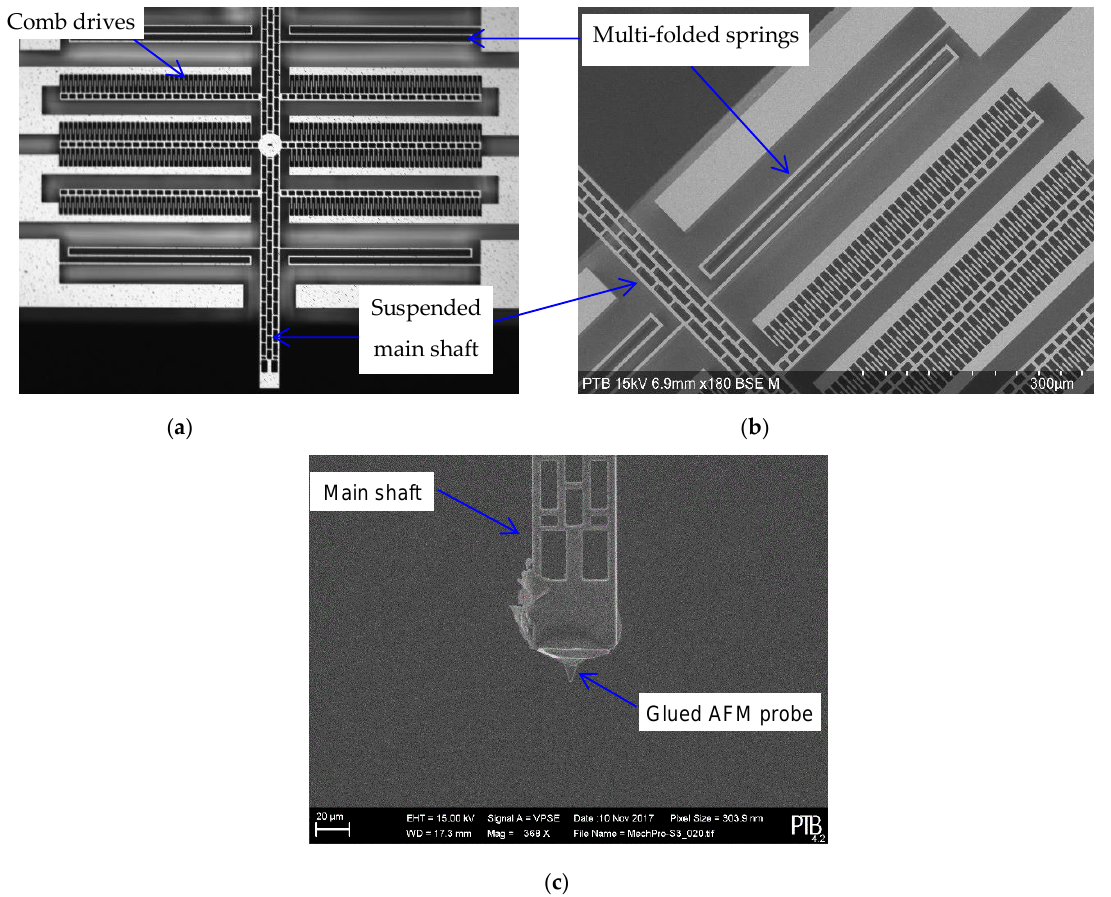
Figure 3. Prototyping of the MEMS-SPM using the bonding-deep reactive ion etching (B-DRIE) technology [16]: ( a ) Microscopic image of the MEMS nano-force transducer with folded springs and electrostatic comb-drive for force and displacement sensing; ( b ) SEM image of the MEMS nano-force transducer; ( c ) prototype of a MEMS-SPM with a glued AFM probe (the diamond coated tip height amounts to ~15 µm).